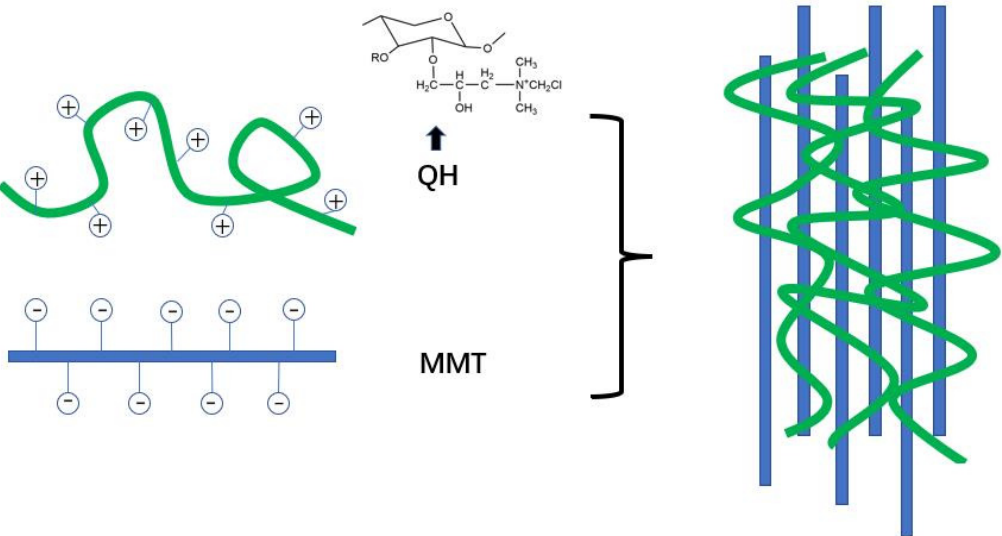
Figure 5. Schematic representation of organic-inorganic composite films prepared by electrostatic interaction between QH and MMT.